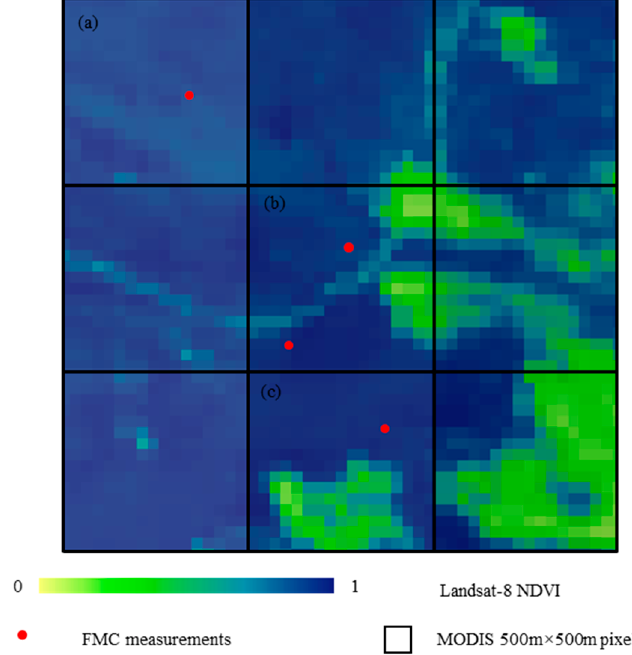
Figure 3. A case showing the spatial location of field plot, Landsat 8 OLI pixel and MODIS pixel. The black boxes indicate the 3 × 3 MODIS grid (1.5 km × 1.5 km). ( a ) homogeneous and ( c ) heterogeneous LFMC measurement plots of vegetation at MODIS spatial resolution and ( b ) an example of a MODIS pixel containing multiple LFMC measurement plots, and 152 field data were finally obtained after calculating the average value of the field LFMC measurements in such a case.